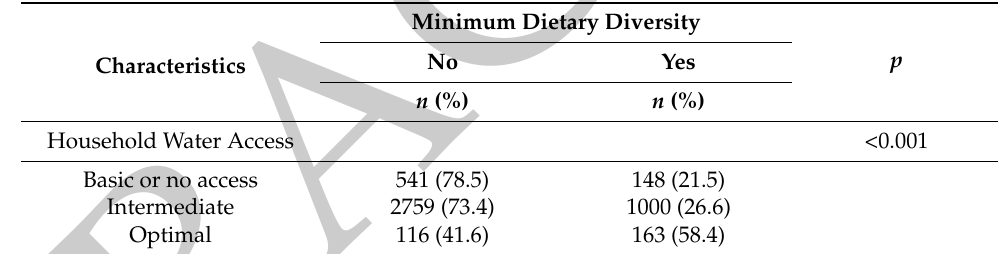
Table 2. Proportion (in %) of infants and young children aged 6–23 months achieving minimum dietary diversity by household water access in Malawi ( n =